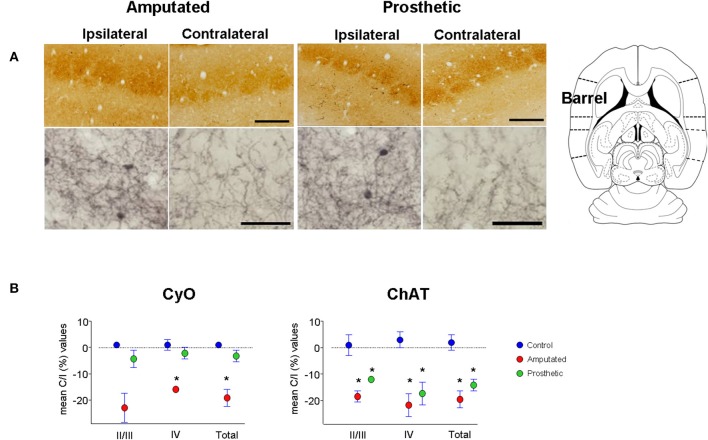
Metabolic activity and cholinergic innervation in the barrel somatosensory cortex after amputation and after artificial stimulation of the transected infraorbital nerve. (A) CyO-reacted and ChAT-immunostained sections are shown in upper and lower row, respectively. Ipsilateral or unaffected hemispheres are on left, contralateral or affected hemispheres are on right. Peripheral deafferentation causes a decrease in gross structure and metabolic and cholinergic states of the affected barrel cortices (Amputated-right). Artificial stimulation of the transected nerve protects the metabolic activity of the affected barrel cortices. It maintains similar CyO-levels between the two hemispheres but does not avoid the deafferentation-dependent degenerative effect on cholinergic innervation (Prosthetic-right). Ipsilateral cortices show significantly lower ChAT-staining levels than the contralateral ones. In ipsilateral hemispheres rostral is right; in contralateral hemispheres rostral is left and lateral is top. Scale bars = 200 μm in CyO; 50 μm in ChAT. (B) Graphic representations of mean OD percentage changes of the contralateral vs. ipsilateral hemispheres indicated as C/I (%). Metabolic activity (CyO, left) and cholinergic innervation (ChAT, right) values of the barrel cortices of control, amputated, and prosthetic animals (represented by blue, red, and green symbols, respectively) are given separately for cortical layers II/III and IV and the whole II-IV field. Values are expressed as mean ± s.e.m. Significant differences are indicated by an asterisk (ANOVA, *P < 0.05).